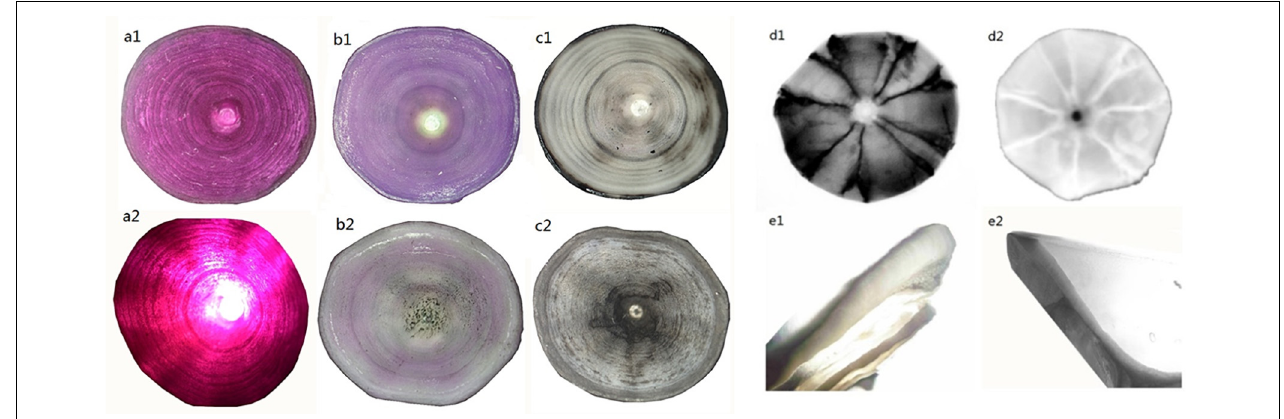
FIGURE 3 | Images of P. kamoharai’s vertebrae with different enhancement techniques under varying light direction and source. Whole centrum (a–d) and coronally sectioned centrum (e) . (a1) Alizarin red S staining method, viewed with reflected light; (a2) Alizarin red S staining method, viewed with transmitted light; (b1) Cobalt nitrate staining method, viewed with reflected light; (b2) Cobalt nitrate staining method, viewed with transmitted light; (c1) Cobalt nitrate and ammonium sulfide staining method, viewed with reflected light; (c2) Cobalt nitrate and ammonium sulfide staining method, viewed with transmitted light; (d1) whole centrum observed through X-Ray-negative phase; (d2) whole centrum observed through X-Ray-positive phase; (e1) sectioned centrum viewed with reflected light; (e2) sectioned centrum viewed with transmitted light.